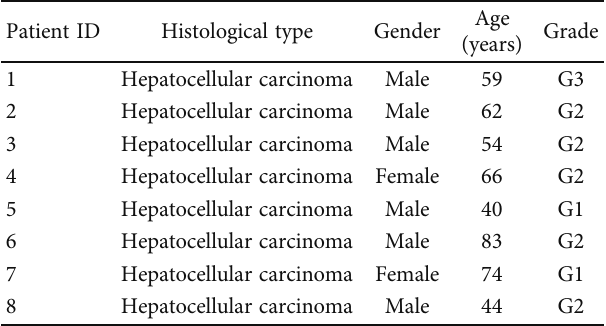
Figure 1: The process of constructing the fi ve-LLPS gene risk score signature. First, 43 di ff erentially expressed LLPS genes associated with OS in HCC patients were identi fi ed by di ff erential expression analysis and univariate Cox proportional hazards regression analysis. Next, Least Absolute Shrinkage and Selection Operator (LASSO) Cox penalized regression analysis was applied to construct a gene risk score signature for prognosis prediction. Then, the gene risk score signature was generated based on fi ve LLPS genes ( BMX , FYN , KPNA2 , PFKFB4 , and SPP1 ). Finally, the fi ve-LLPS gene risk score signature was validated by the validation dataset and clinical samples using experiments. Table 1: Information of patients included in the